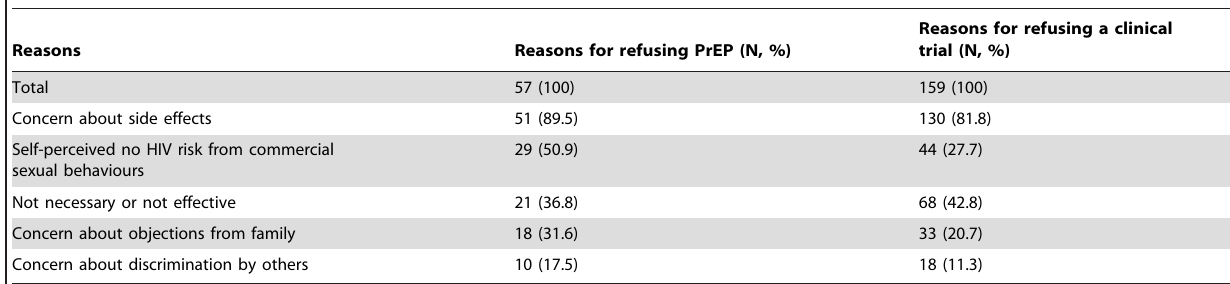
Table 3. Reasons for refusing PrEP or participating in a clinical trial.